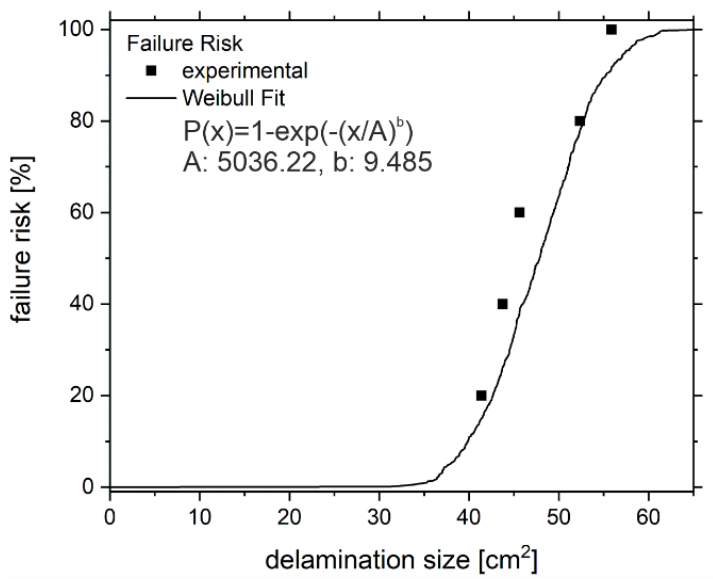
Figure 6. Failure risk as a function of the delamination size based on experimental data (B-series, black dots) and a Weibull-Fit (black line).